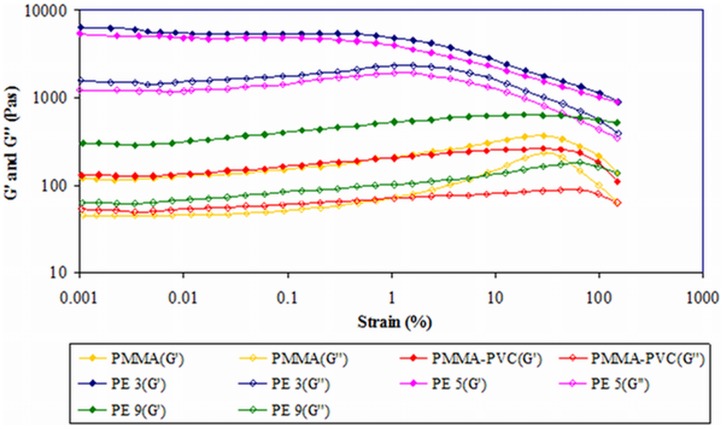
Amplitude sweep of first system.